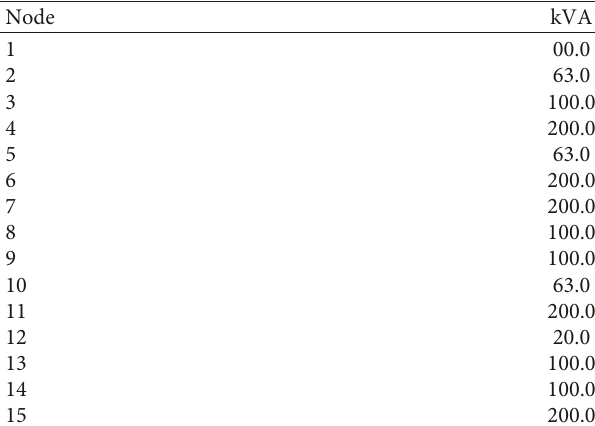
Table 4: Load data of the 15-bus system.